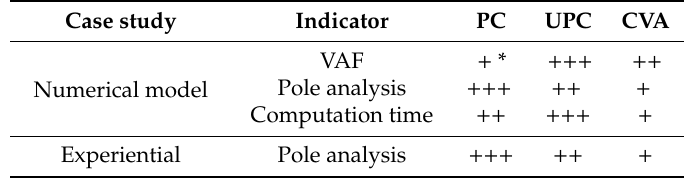
Table 2. The results of the comparative study for PC, CVA, and UPC algorithms. Case study Indicator PC UPC CVA + * +++ ++ VAF +++ ++ + Pole analysis Numerical model Computation time ++ +++ + Experiential Pole analysis +++ ++